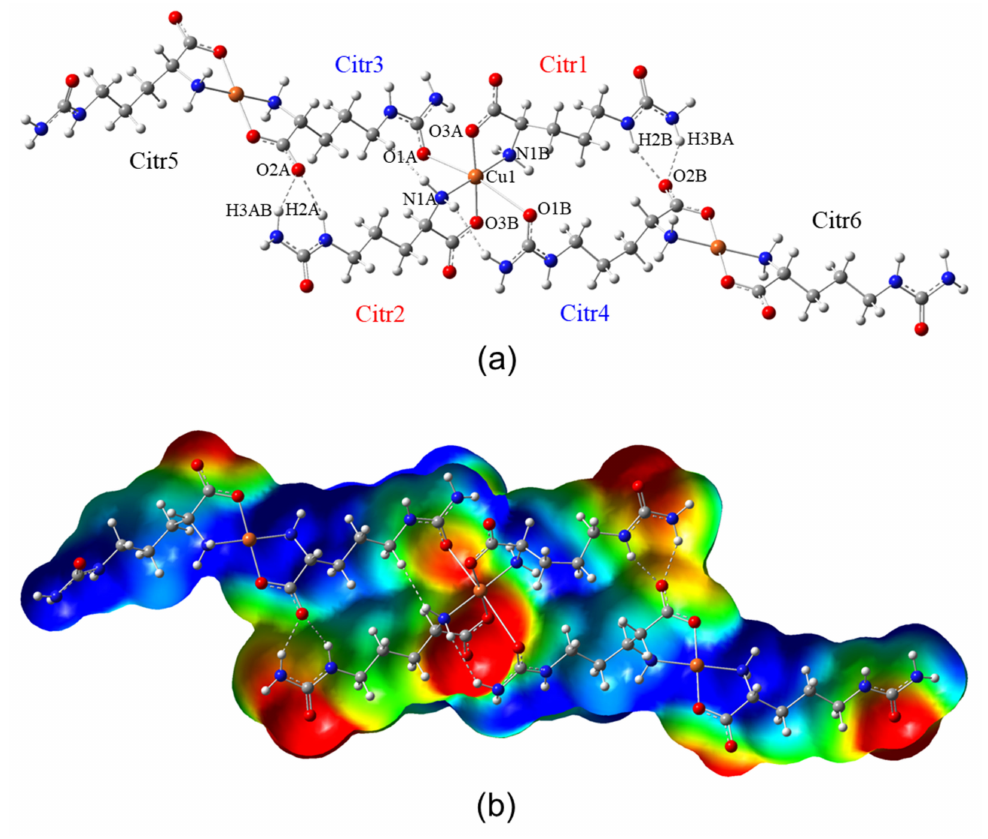
Figure 10. ( a ) Molecular structure of a representative triad of the compound. ( b ) Molecular electro- static potential of compound [Cu(Citr) 2 ] n calculated at the level of theory mPW1PW91/6-31G(d)- LANL2DZ and ECP=LANL2DZ.